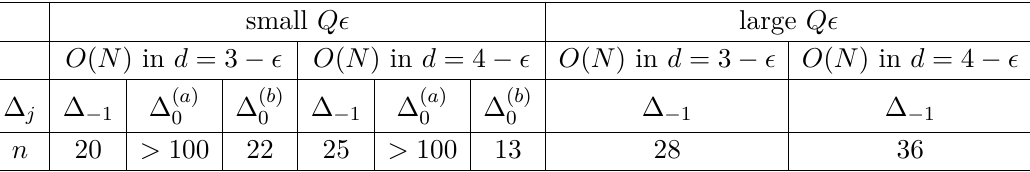
Table 1 . Number of expansion coefficients needed to determine, with a 5 digits accuracy, the position ( x ), type ( p ), and amplitude ( f ( x 0 ∆ in the O ( N ) model in d = 3 − (cid:15) and d = 4 − (cid:15) dimensions. In the case of ∆ j contribution of ∆ ( a )